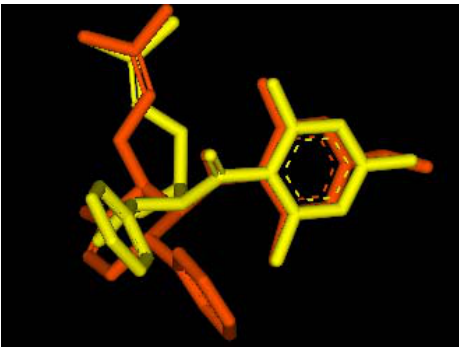
Figure 2. Superimposition of the competitive inhibitor structures, 4-hydroxypanduratin A (yellow) and panduratin A